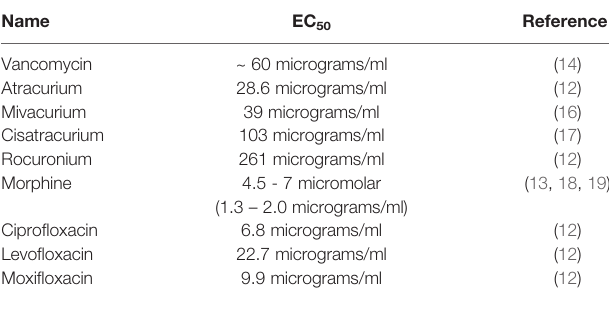
TABLE 1 | Calculated EC50 values for selected MRGPRX2